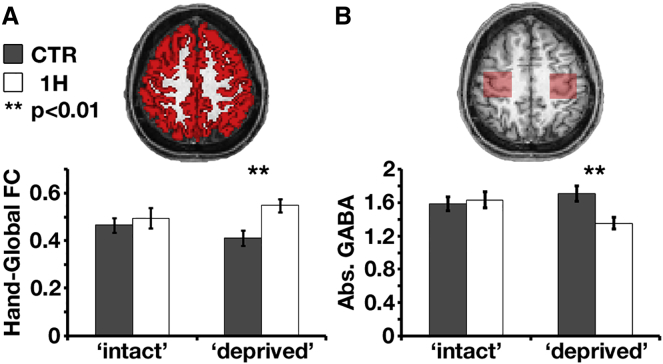
Large-Scale Reorganization in One-Handers, Potential Mechanism(A) Top: resting-state global signal was defined as the averaged time course of gray-matter voxels (red) across the entire brain (illustrated in one participant). Bottom: one-handers’ missing-hand territory (white bars) showed increased coupling with the global signal compared to controls’ nondominant-hand territory (gray bars).(B) Top: illustration of two voxels (red) placed over the bilateral hand knobs, used to extract absolute GABA concentrations using MR spectroscopy. Bottom: one-handers’ missing-hand territory showed reduced GABA concentrations compared to controls’ nondominant-hand territory, suggesting reduced inhibition in the missing-hand territory. FC, functional connectivity. Other annotations are as in Figure 2. Error bars depict SEMs.See also Figure S2.